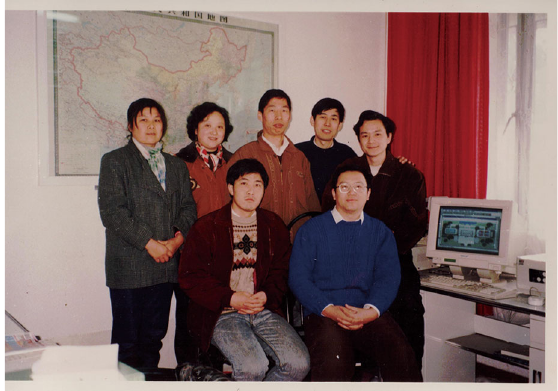
Figure 2. Youth Laboratory of Computational Biology, Wuhan Insitute of Botany, CAS